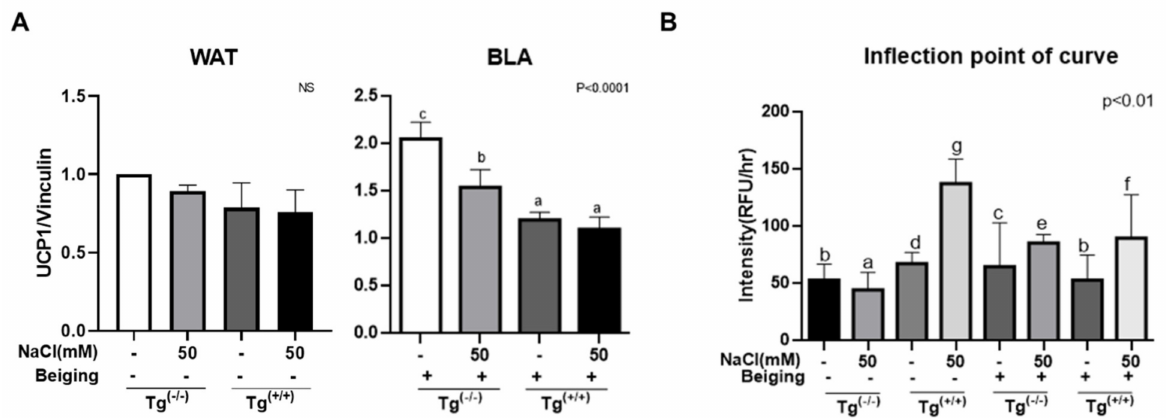
Figure 4. Beiging biomarker, UCP-1, was increased in BLA, but it was decreased by salt treatment and MEK6 transfection. ( A ) Oxygen consumption intensity (RFU/h) in salt treated-WAT and BLA with Tg (+/+) and without Tg (+/+) were measured at the time of an inflection point of curve in 8th day-culture when cells were completely differentiated and alive. ( B ) Significant differences for individual treatments versus controls are indicated by ANOVA test with different superscript letters letters (a, b, c, d). (NS; non